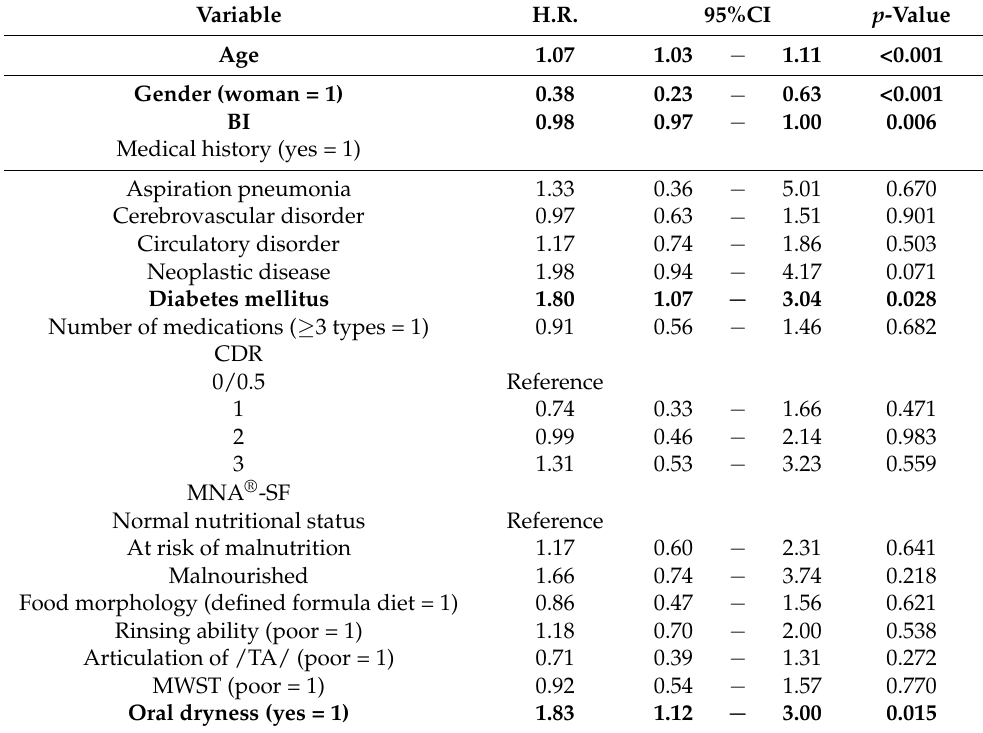
Table 2. Predictors of mortality according to Cox proportional-hazards